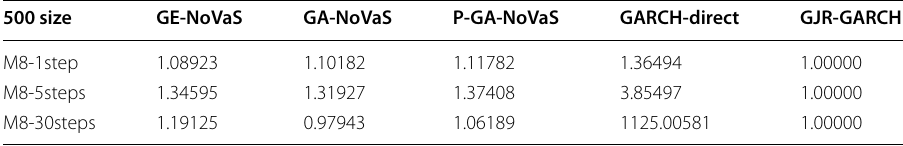
Table 11 Comparison results of NoVaS-type, GARCH(1,1) and GJR-GARCH(1,1) methods on forecasting 500 size simulated Model 8 data